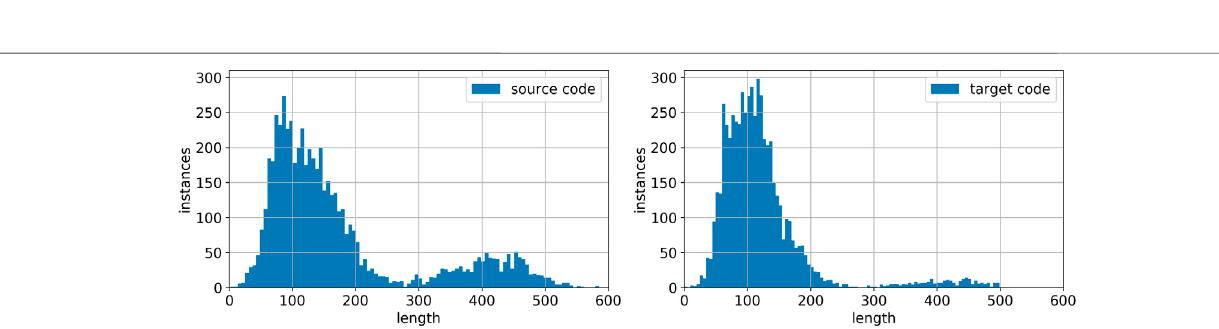
FIGURE 7 | Histogram of fl awed code (left) and repaired code (right)